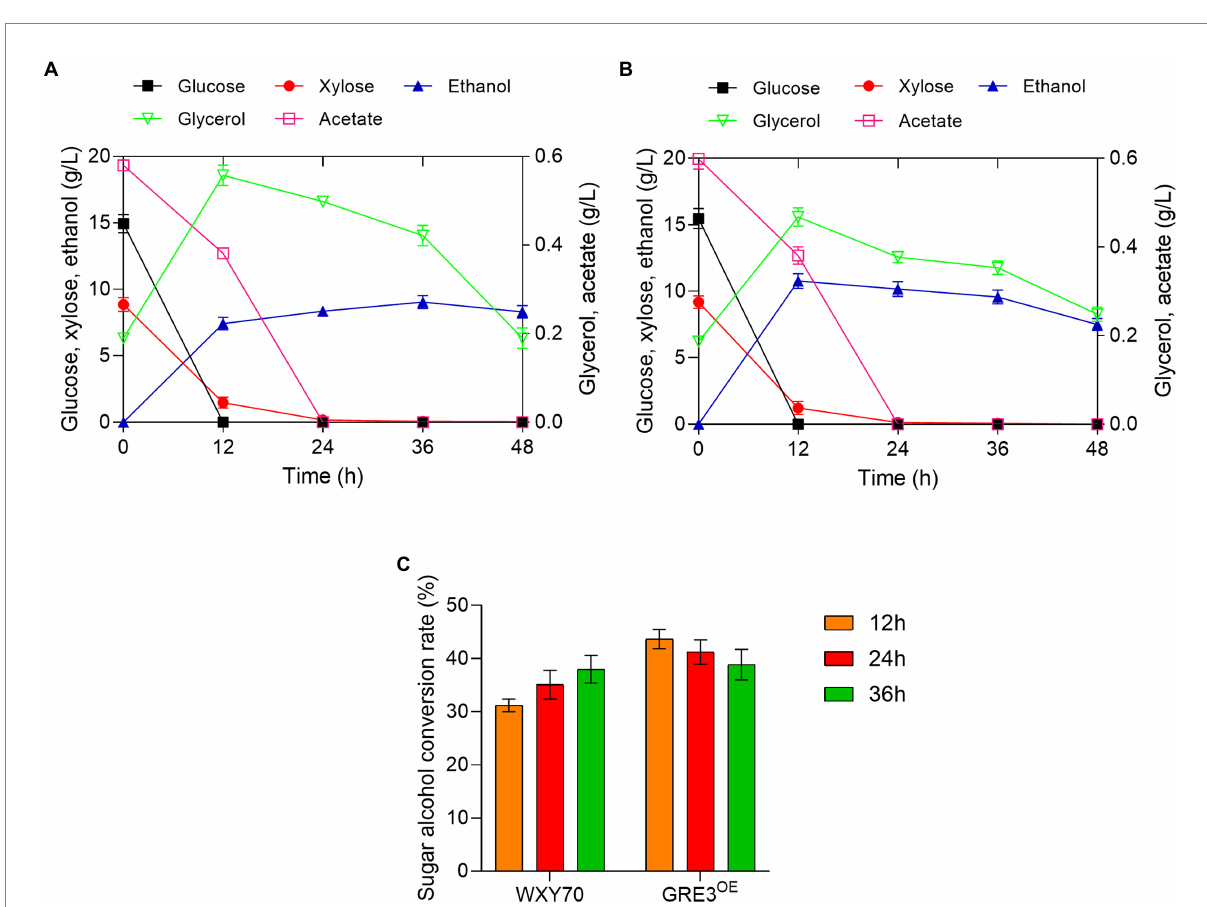
FIGURE 2 Profiles of strain WXY70 and GRE3 OE during fermentation and growth in alkaline-distilled sweet sorghum bagasse hydrolysate solution. Fermentation and growth profile of WXY70 (A) and GRE3 OE (B) within 48 h. (C) The sugar alcohol conversion rate of WXY70 and GRE3 OE at 12 h, 24 h, and 36